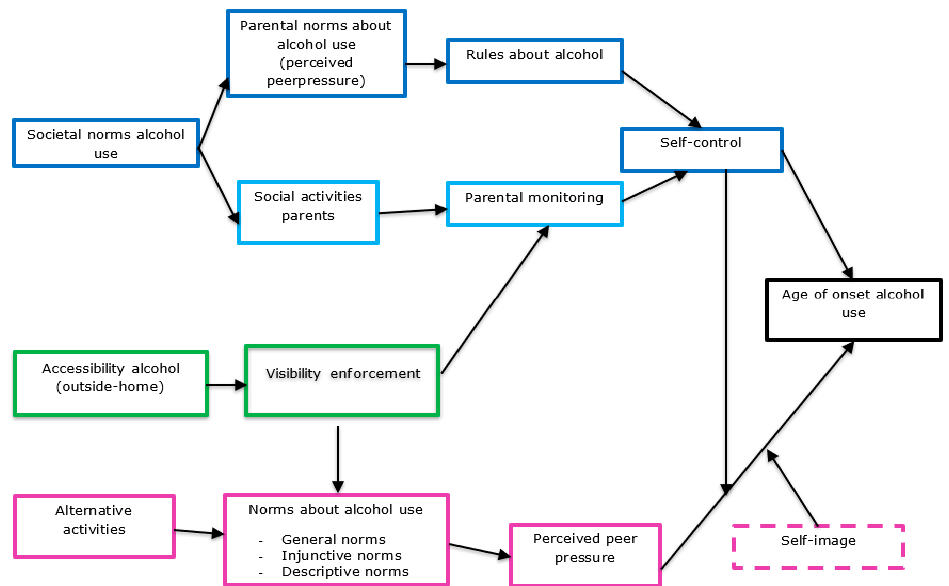
Figure 1. Explanatory Model including Important and Changeable Determinants of Behavior for Onset of Alcohol Use among Youth.